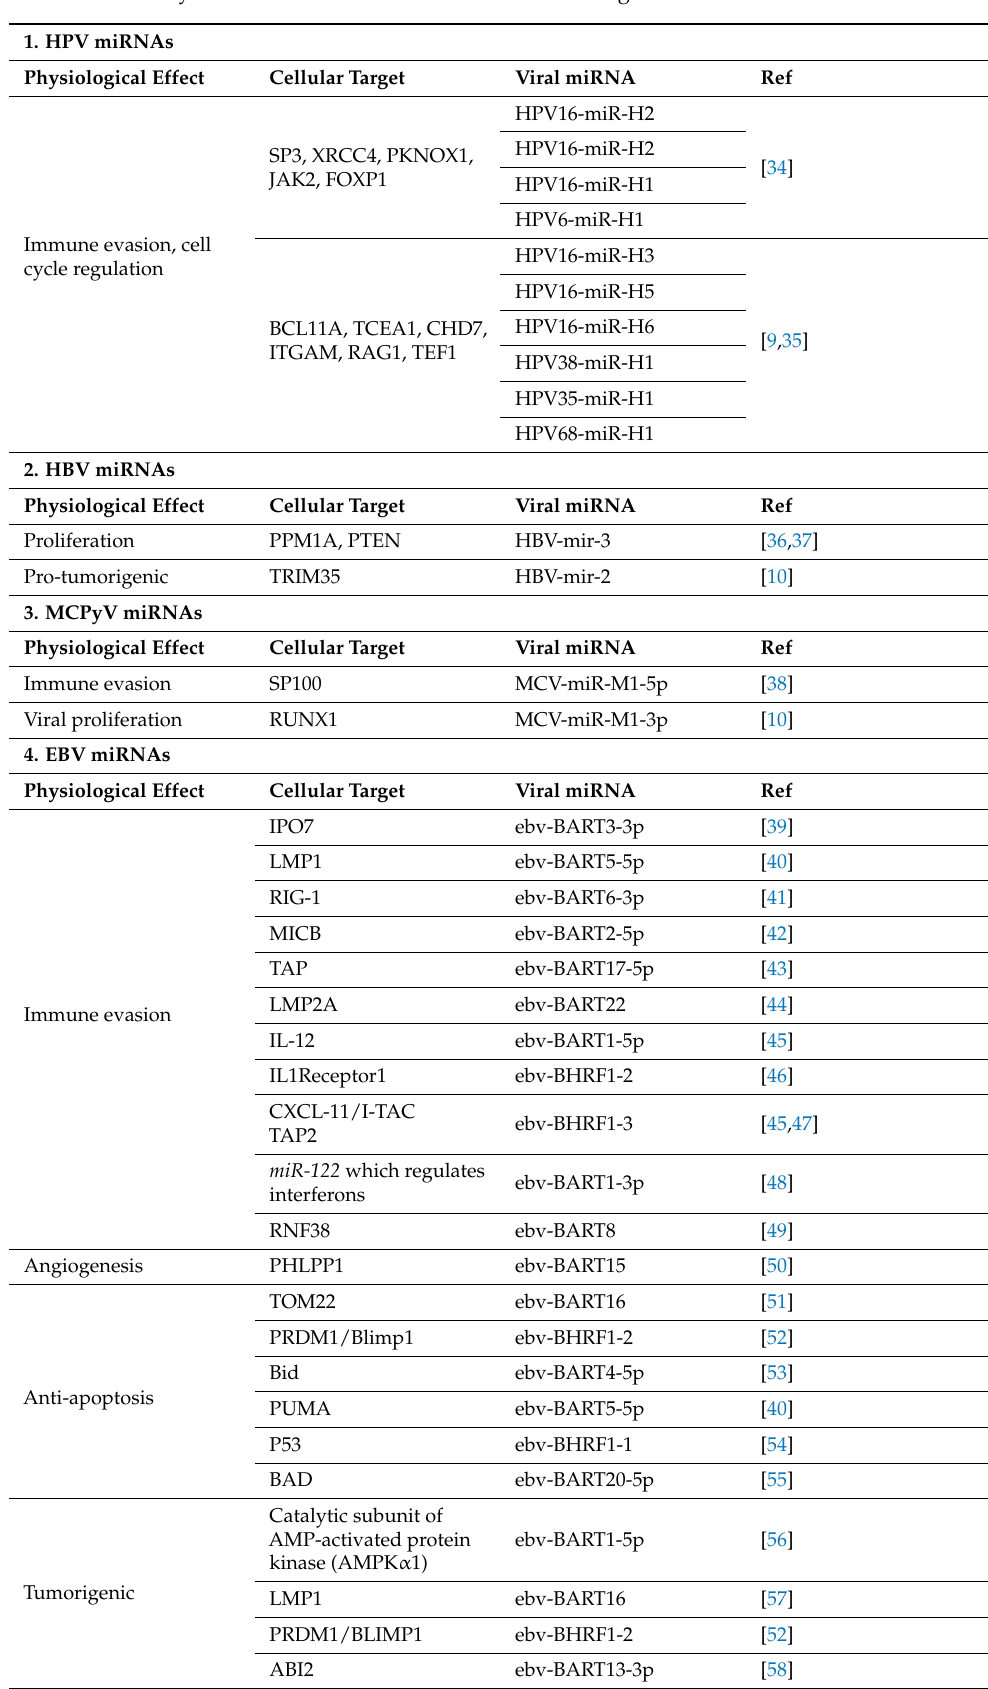
Table 1. Summary of known viral miRNAs with roles in